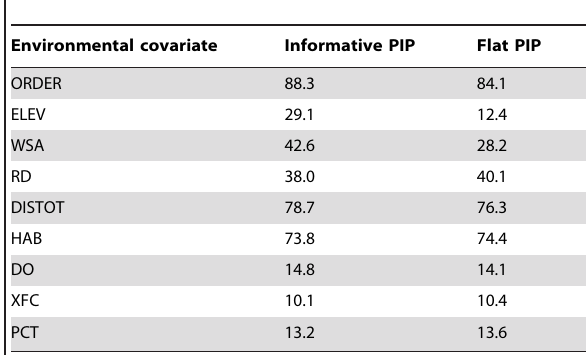
Table 6. Posterior inclusion probabilities (PIP) for the MAHA pollution intolerant fish